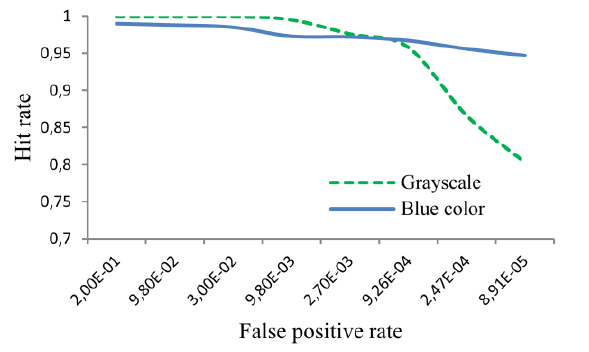
Figure 3: ROC curve for cascades trained with gray and color features.